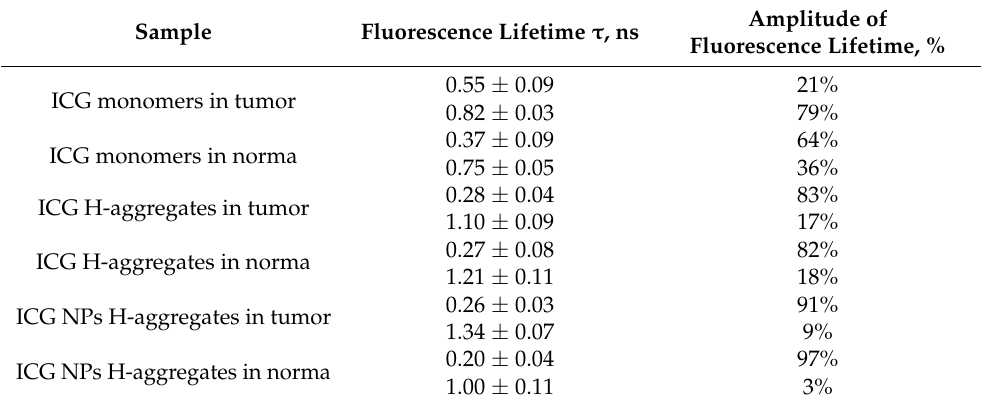
Table 1. Fluorescence lifetime of ICG in monomeric and aggregate forms in tumor and healthy tissue.